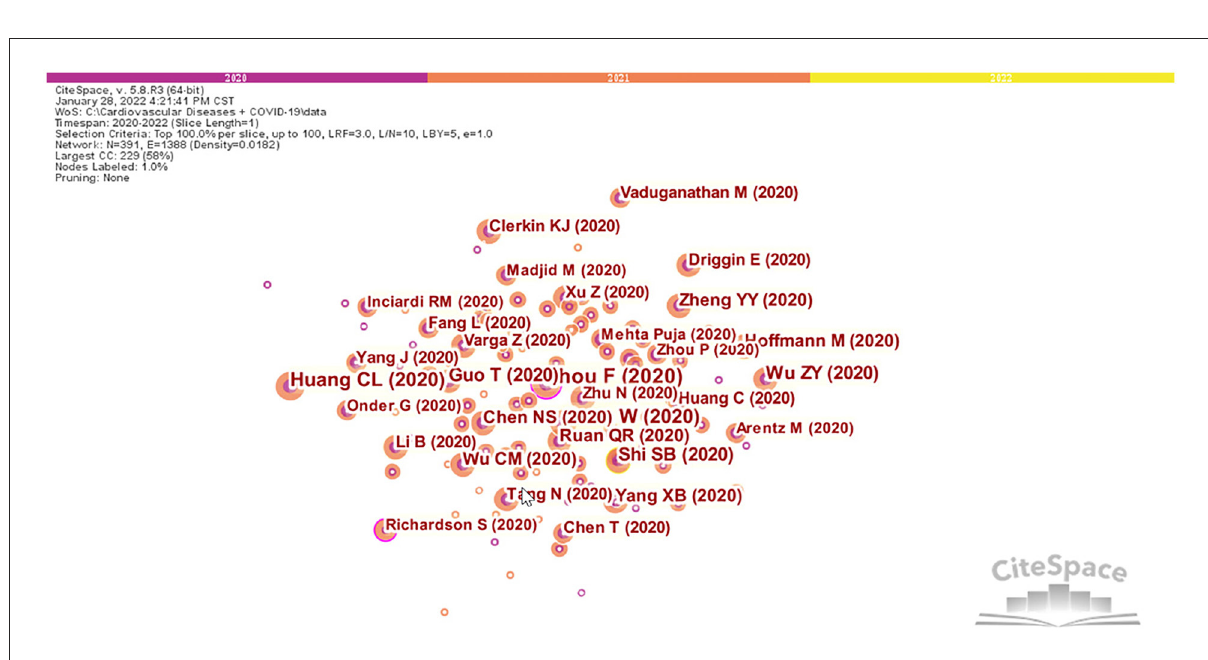
FIGURE6 References co-citation network in the studies of CVDs and COVID-19 research.